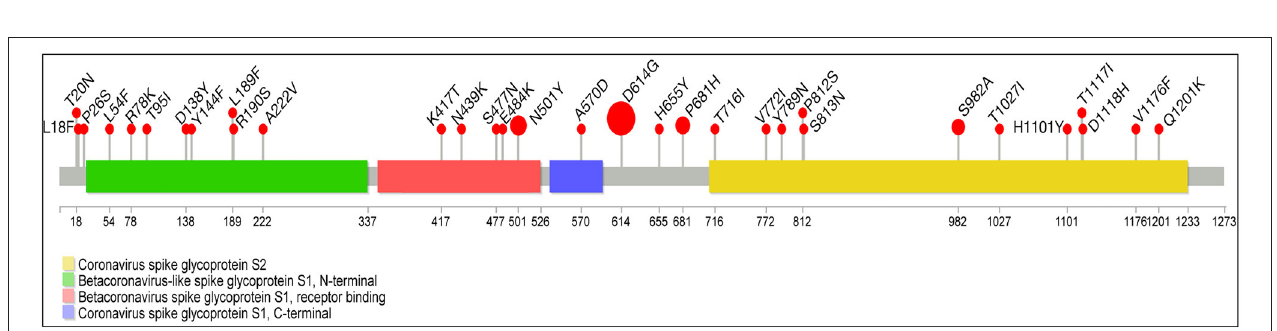
FIGURE 4 | Lolliplot graph with mapping missense mutations in spike protein. Lollipop plot summarizes the frequency of SARS-CoV-2 mutations with prevalence ≥ 2% in our study cohort ( n = 101). A SARS-CoV-2 genome map with base-pair positions is shown at the bottom. Mutation frequencies and details are indicated on the red bubbles. Spike protein domains are indicated by four different colors: green, Betacoronavirus-like spike glycoprotein S1, N-terminal; red, Betacoronavirus-like spike glycoprotein S1, receptor binding; violet, coronavirus-like spike glycoprotein S1, C-terminal; yellow, coronavirus-like spike glycoprotein S2. The size of the circle is related to the number of samples with a specific